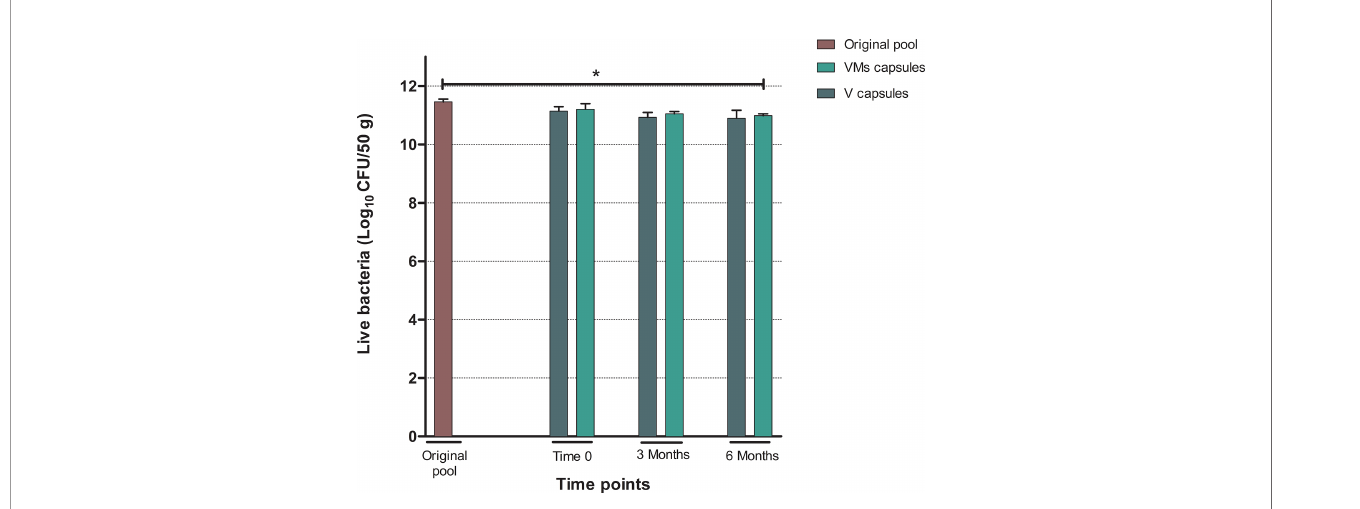
FIGURE 5 | Results from fl ow cytometry analysis corresponding to the number of viable bacteria expressed as the mean of Log 10 CFU/50 g of feces (SD). VM capsules: adsorbate capsules with Vivapur-101 ® in combination with magnesium stearate. V capsules: adsorbate capsules with Vivapur-101 ® only. Statistical signi fi cance